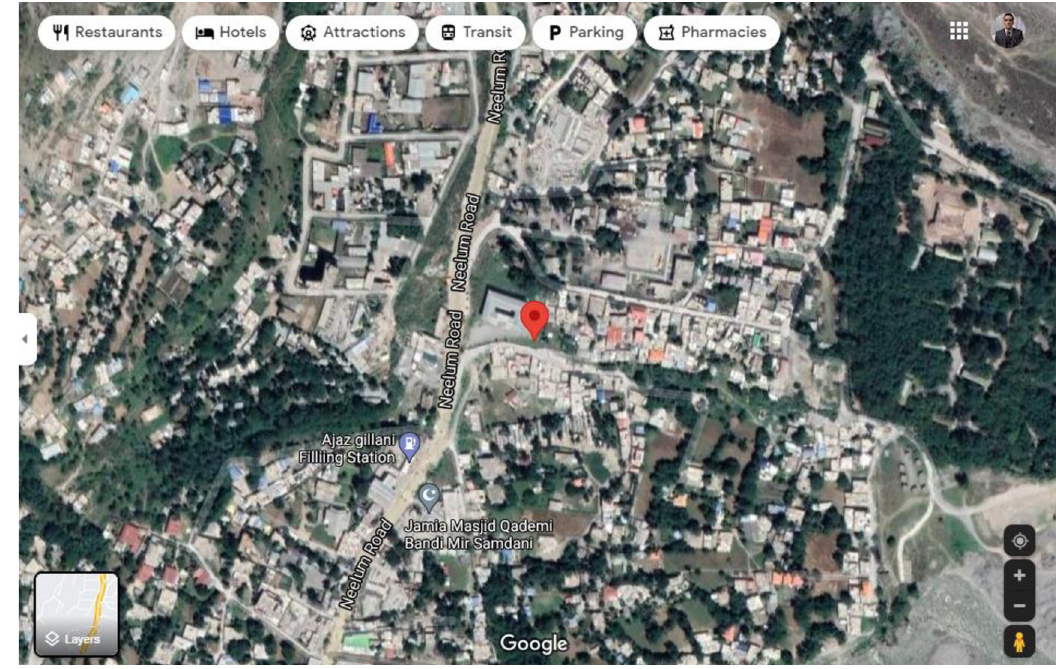
Fig 1. Soil radon measuring station located inside 150 km from the epicentre of the strongest earthquake since 1900 with the latitude, longitude of 34.39621 and 73.47347 respectively.